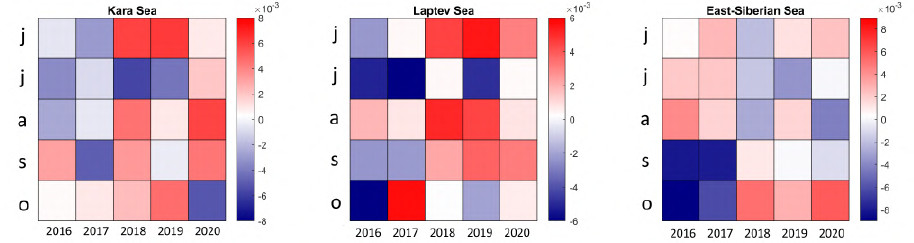
Figure 13. The eastern component of the monthly (from June (j) to October (o)) mean sea level pressure gradient (NCEP/NCAR [42]) averaged along a circle of 75 ◦ N latitude over the Siberian Arctic seas (hPa/km).